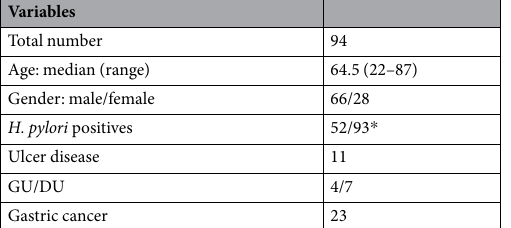
Table 1. Clinicopathological characteristics of subjects. * For one case, H. pylori status was not determined. GU, gastric ulcer; DU, duodenal